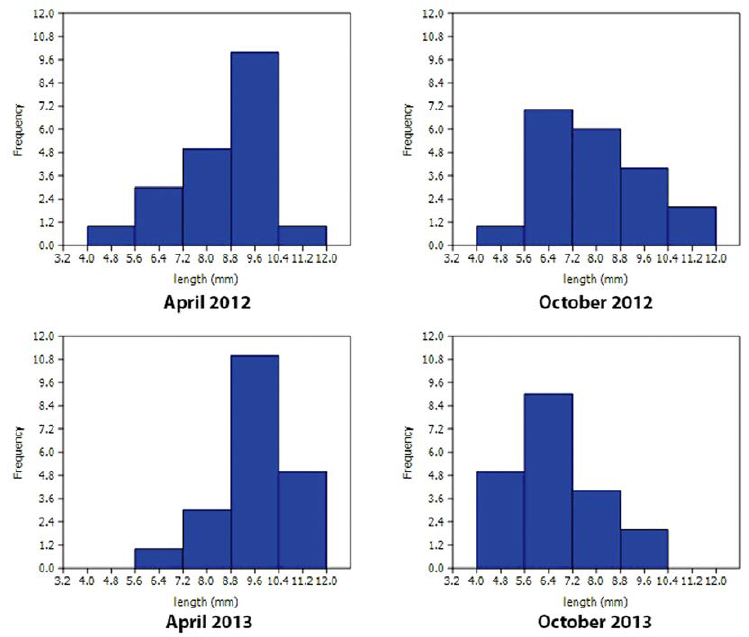
Fig. 3 . – Sabellaria spinulosa. Size-frequency histograms.